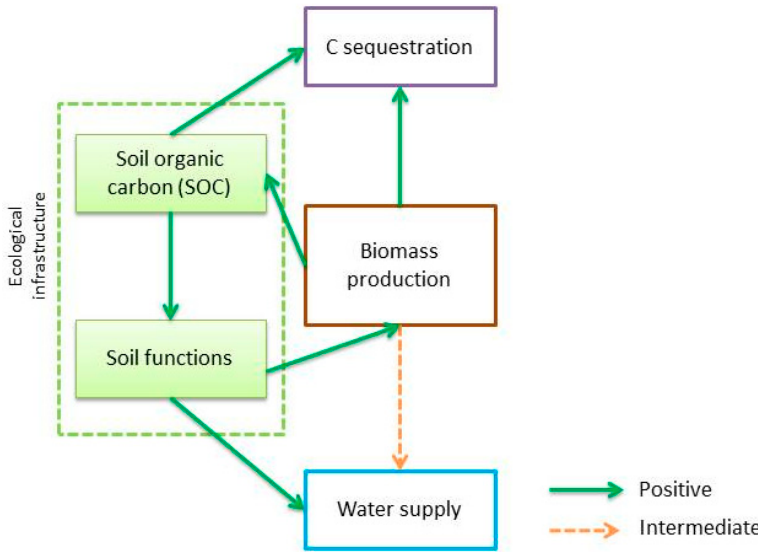
Figure 6. Relationship between ecosystem services, soil organic carbon, and soil functions in a scenario of no timber extraction. Note that the maximum water supply would be achieved with an intermediate tree density [63].